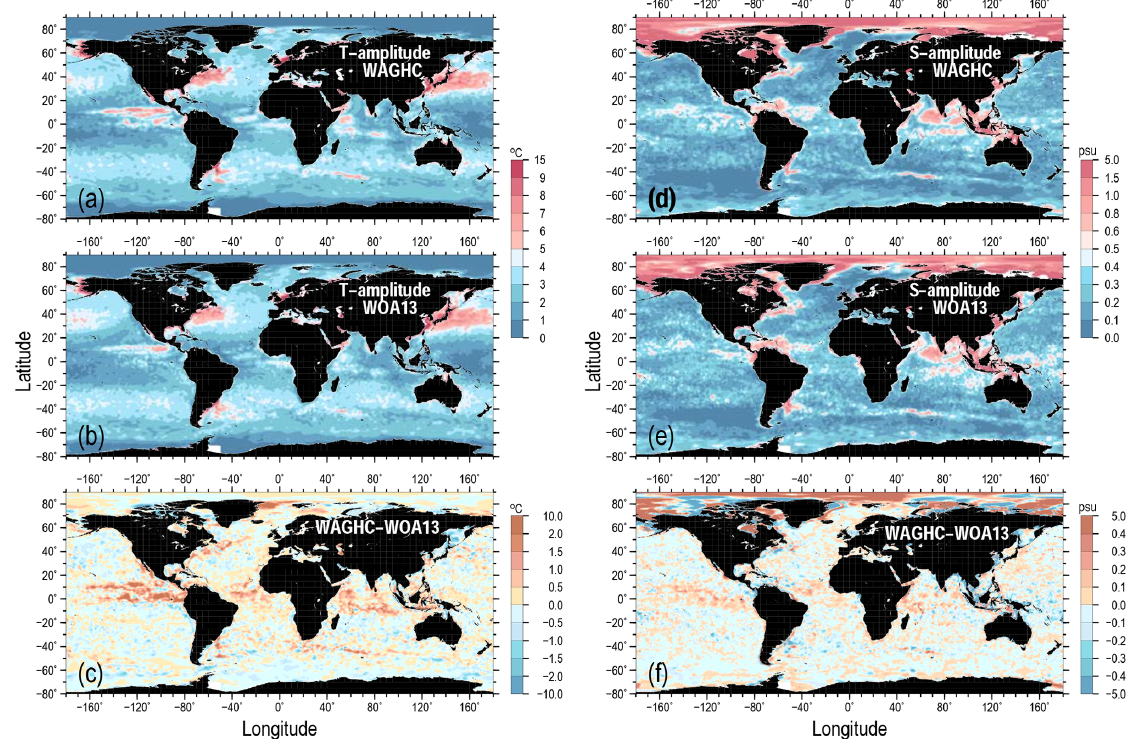
Figure 16. Annual cycle amplitudes for temperature ( a – WAGHC, b – WOA13) and salinity ( d – WAGHC, e – WOA13) averaged over the upper 100m layer for the WAGHC and WOA13 climatologies. Amplitude difference WAGHC minus WOA13 for temperature (c) and salinity (f) .